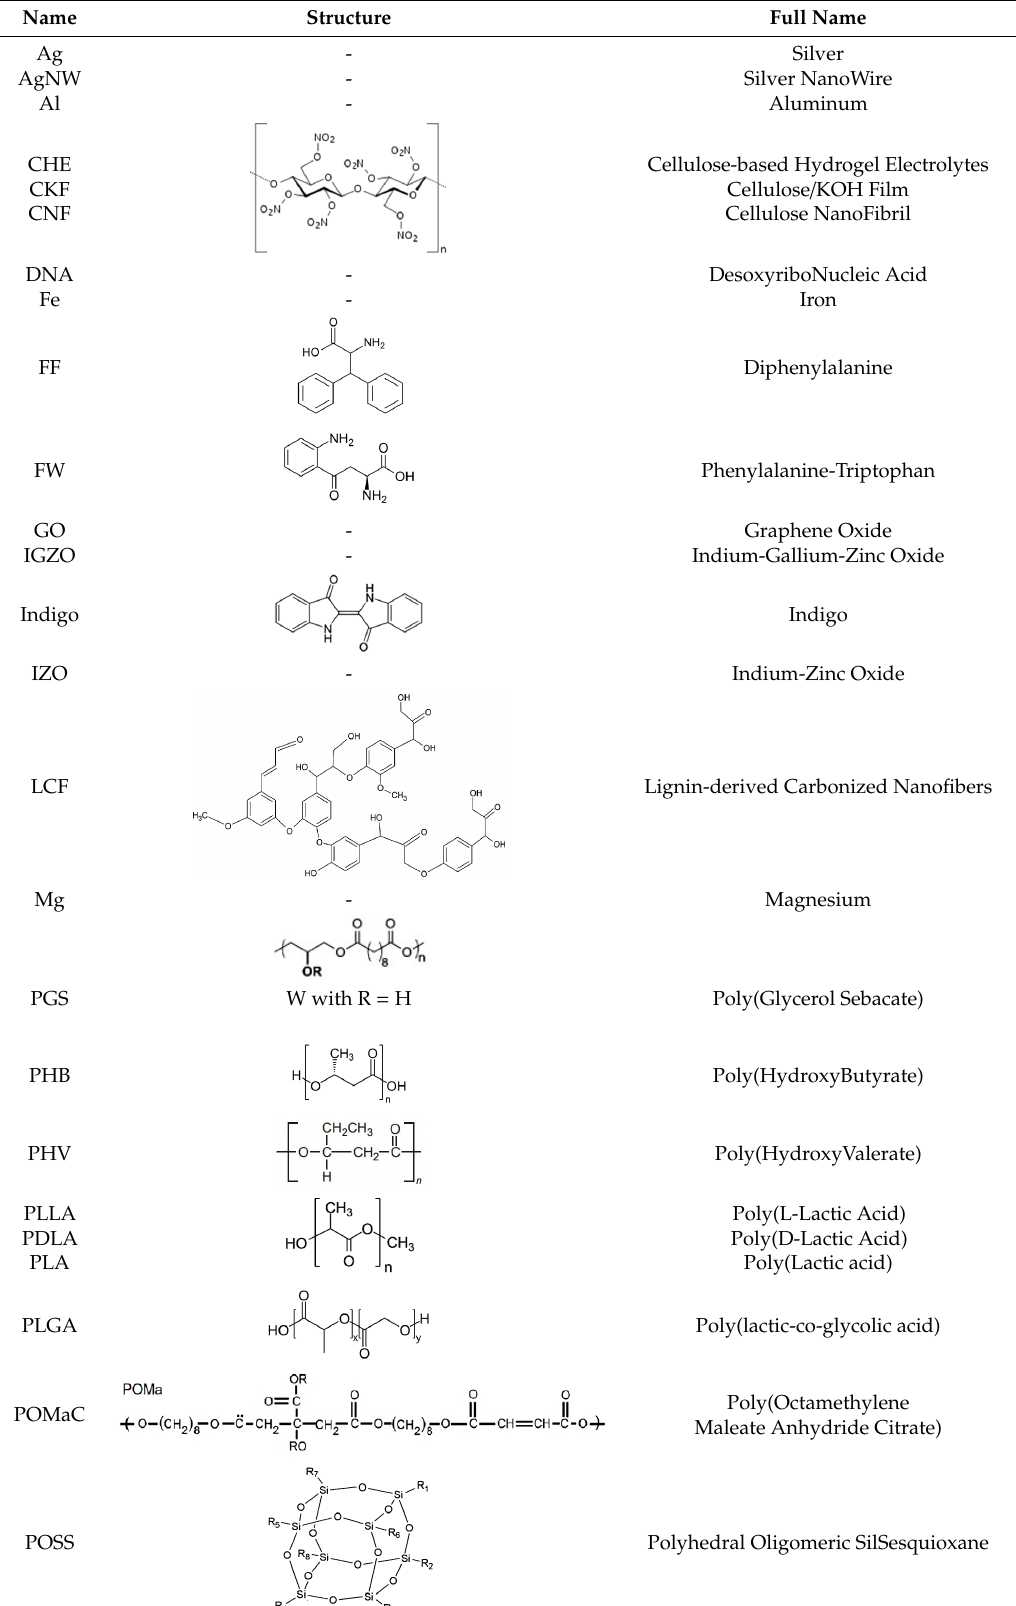
Table 2. Di ff erent kind of (bio)degradable materials currently used in green electronics. Table 2. Different kind of (bio)degradable materials currently used in green electronics.